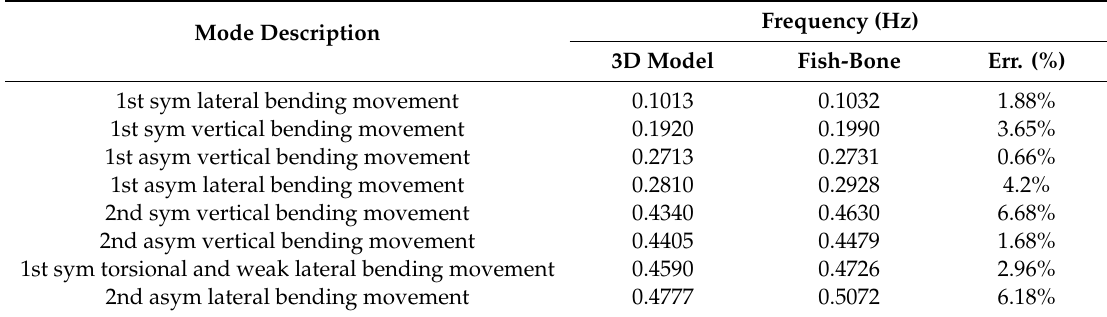
Table 7. Comparison of the primary natural frequencies and mode descriptions of the 3D and fish-bone models.